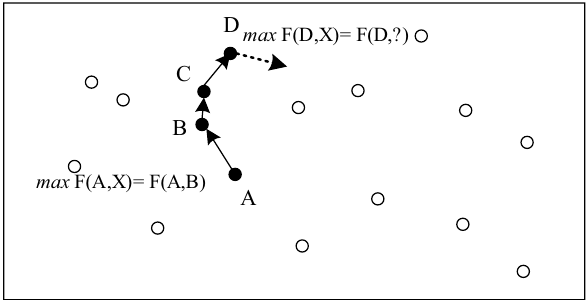
Fig. 2 Initial path generation based on greedy